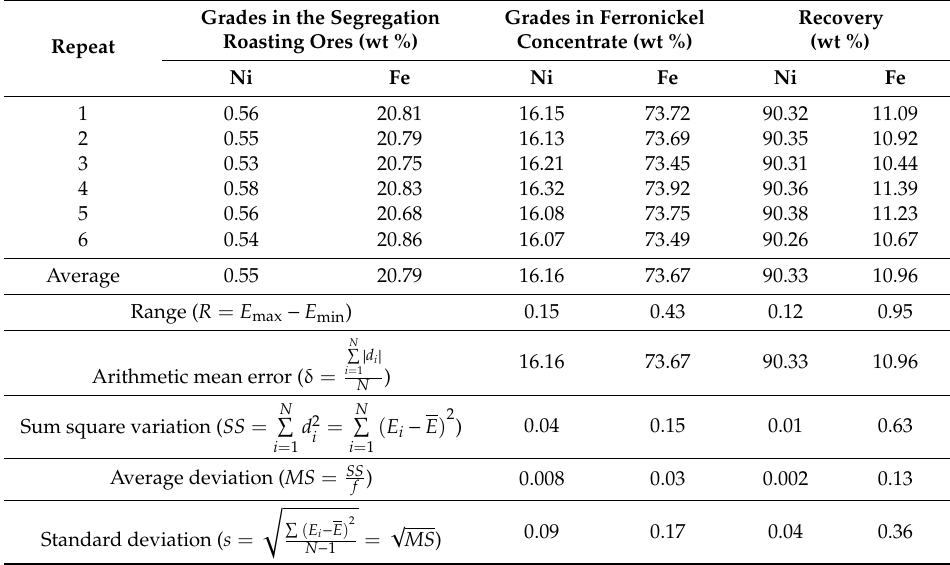
Table 4. Repeated scale-up test results of extraction from the garnierite laterite ore by roasting– magnetic separation.